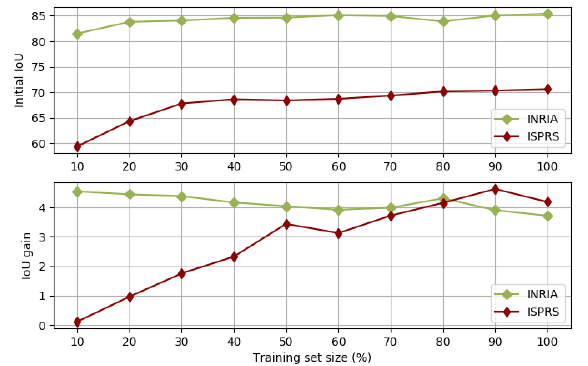
Figure 8. Influence of the training set size on the initial IoU (top) and on the IoU gain (bottom)